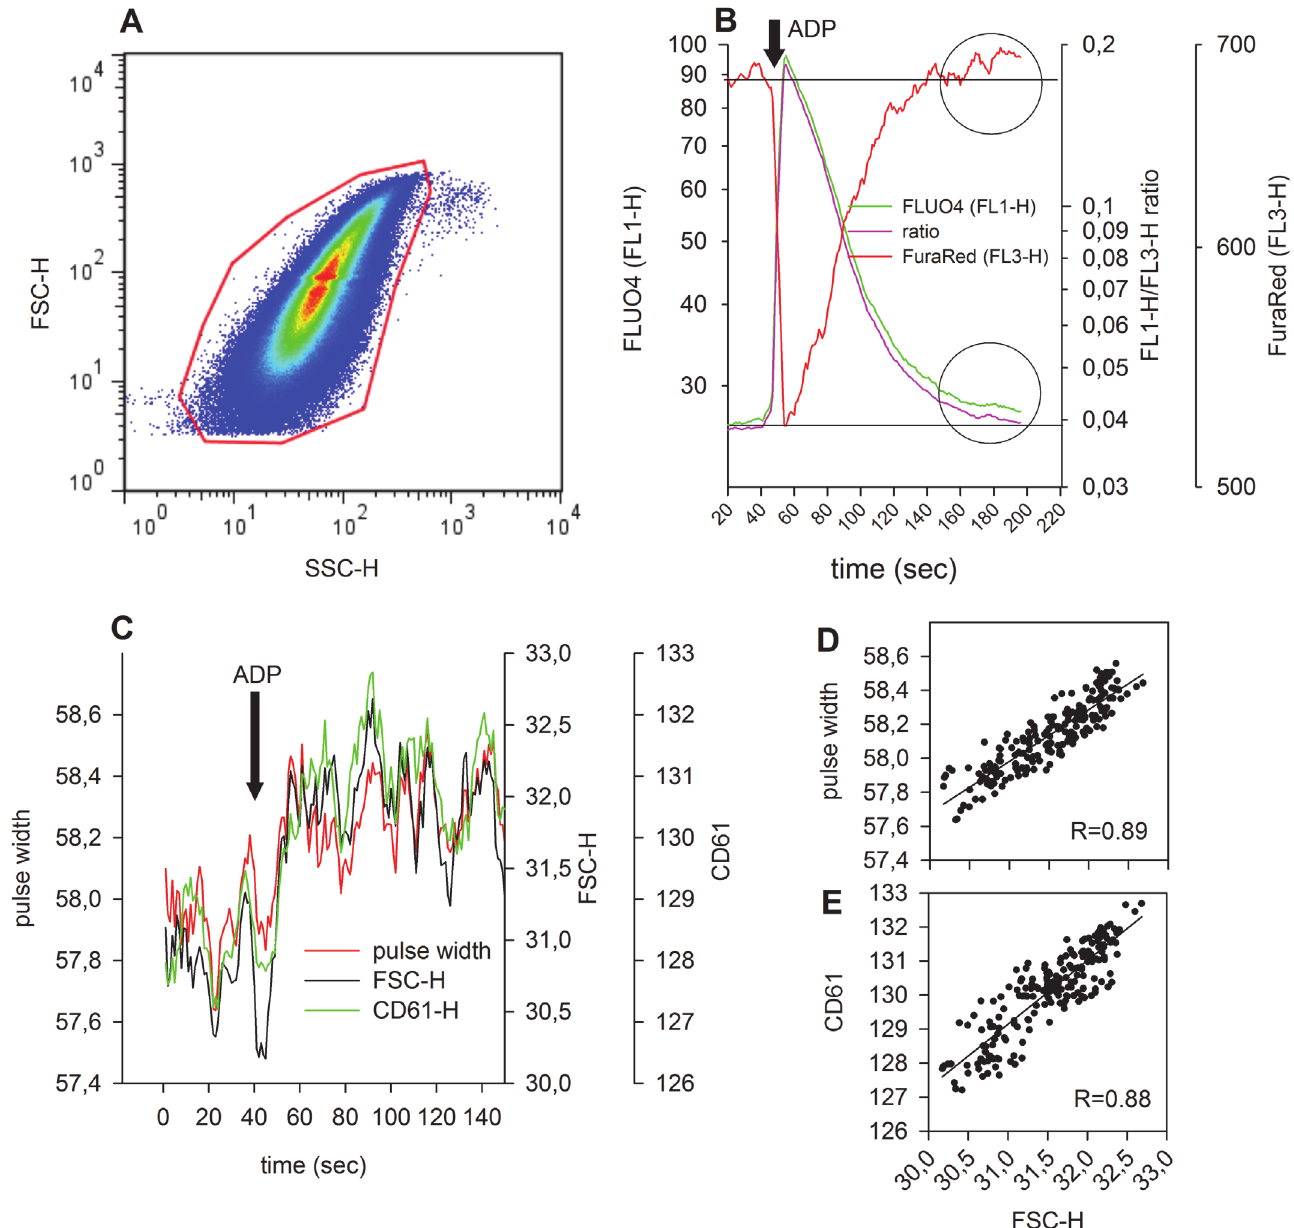
Fig 3. Alterations of detected events in size, pulse width and fluorescence over time: (A) density dot plot of FSC/SSC; red gate = platelet population. (B) Time average of FL1 (Fluo-4, green), FL3 (Fura Red, red) and FL1/FL3 ratio (pink) before and after addition of ADP at 45 seconds, as indicated by an arrow. FL1 and FL1/FL3 ratio are depicted in a way as such that basal, as well as maximum responses are super imposable in the graph. Horizontal dotted line represents the basal unstimulated levels of FL1 and FL1/FL3 ratio. Horizontal dashed line shows the basal FL3 level. Two circles indicate the deviation from baseline of FL1 and FL3, respectively, which cannot be seen with the FL1/FL3 ratio, about 120 seconds after ADP stimulation. (C) Time averaging of FSC, pulse width and CD61 (FL4) events (medians). Addition of ADP is indicated by an arrow. (D) Correlation between pulse width and FSC during ADP stimulation in platelets. (E) Correlation between CD61 (FL4) and FSC during ADP stimulation in platelets. In (D) and (E) the solid line illustrates the correlation between the parameters as a linear regression line. The corresponding correlation coefficients are given as insets.